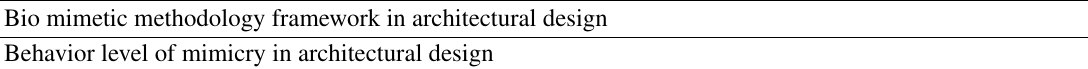
Table 3. Bio mimetic of architectural form at behavior level Source: collated by the